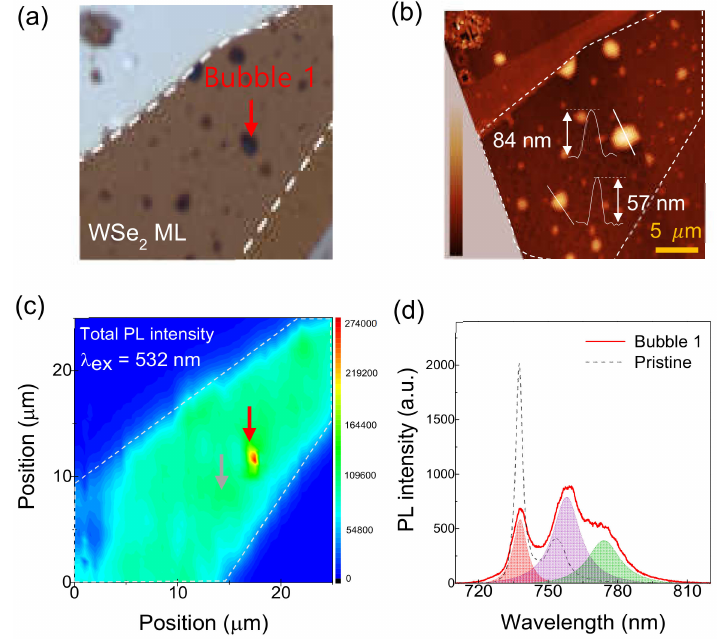
Figure 2. ( a ) Magnified microscope image of the sample in Figure 1a. ( b ) Atomic force microscope image of the same region. ( c ) Spatially resolved PL with an excitation wavelength of 532 nm. Total PL intensity is shown via contour plot from the same region. The red and gray arrows indicate the measured bubble 1 and pristine sites, respectively. ( d ) PL spectra of the bubble and pristine areas shown with solid red and dotted gray lines,